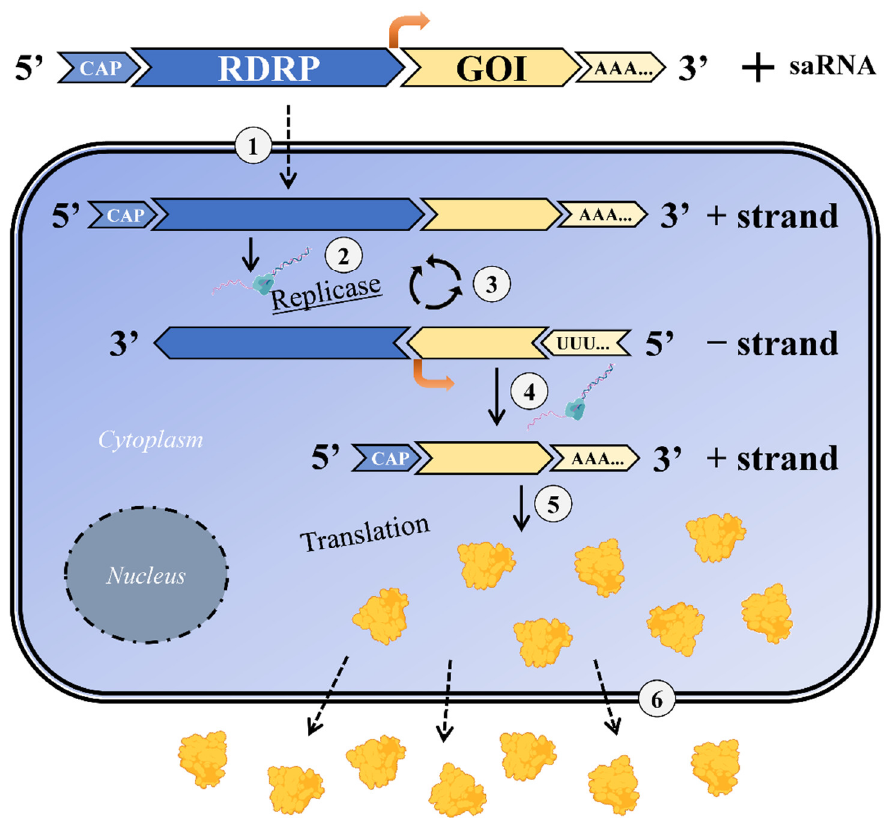
Figure 2. saRNA mechanism of action. 1. saRNA enters the cells; 2. Replicase is translated which uses saRNA as a template to make a complementary negative saRNA (-saRNA) strand; 3. Self-amplification takes place: replicase also uses this -saRNA as a template to make more positive saRNA (+saRNA); 4. In addition, replicase can recognize the sgPr in the negative strand from which a sgRNA of positive polarity (+sgRNA) is synthesized; 5. sgRNA is then translated into desired antigen or protein at very high levels; 6. Protein is released from the cell. RDRP, RNA-dependent RNA polymerase; GOI, gene of interest; saRNA, self-amplifying